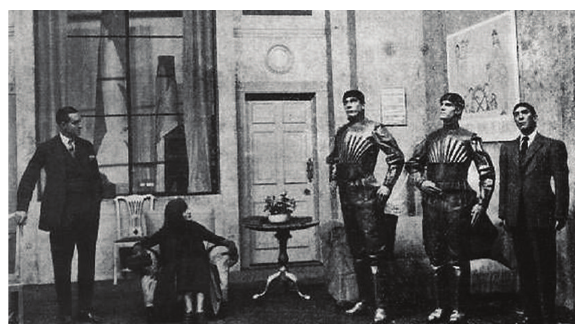
Figure 1: A scene in ˇCapek’s play Rossum’s Universal Robots (1921) showing three robots , adapted from [4].